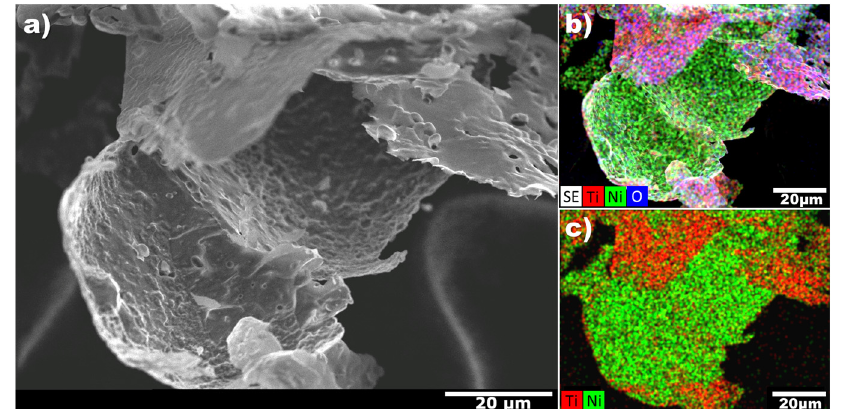
Figure 6. Elemental distribution analysis: ( a ) SEM image; and ( b , c ) EDS elemental maps of the same washed-off C-TiO 2 +Ni particle. Green color in EDS mapping—nickel; red—titanium; blue—oxygen; pink—received as a “sum” of red and blue colors (in titanium oxide phase).